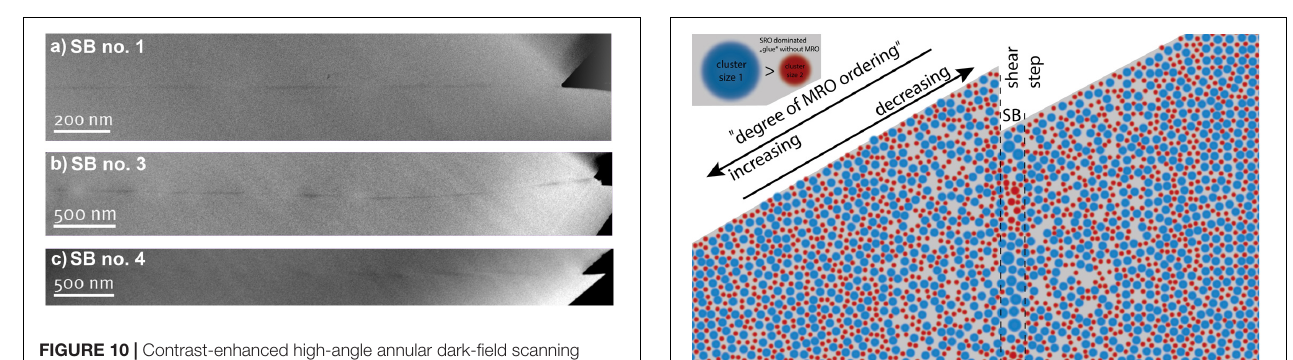
FIGURE 10 | Contrast-enhanced high-angle annular dark-field scanning transmission electron microscopy (STEM-HAADF) micrographs showing shear bands in Vit 105 with alternating contrast changes. (a) shows a shear band (no. 1) that is aligned edge-on to the electron beam; (b) shows a shear band (no. 3) that bends toward the surface; and (c) shows shear band (no. 4) that is twisted and thus misaligned to the electron beam.